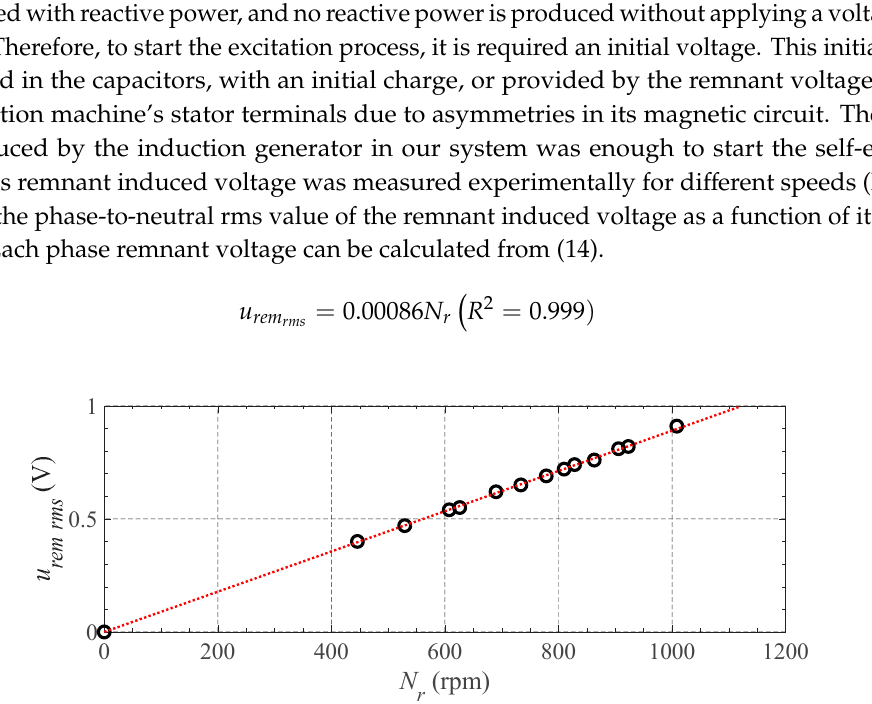
Figure 3. Induced remnant voltage of the induction machine for different rotational speeds.